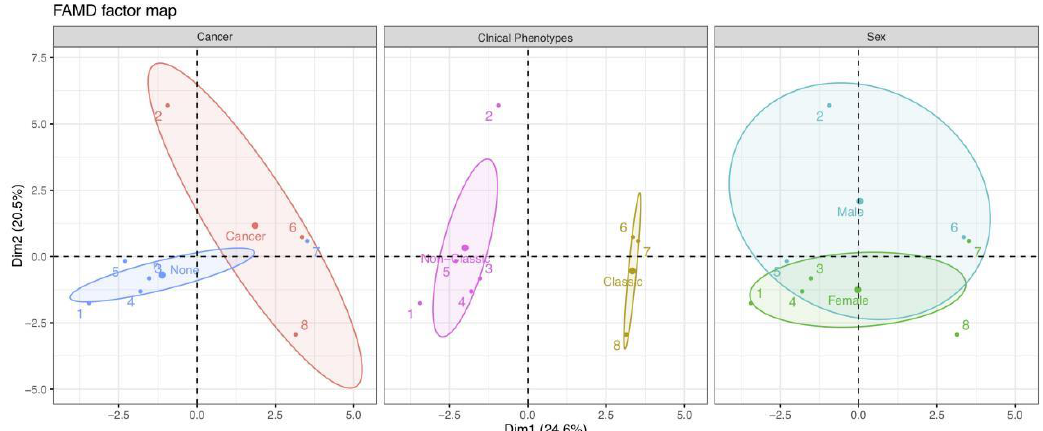
Figure 5. Individual plots corresponding to the classification features of cancer, clinical phenotypes, and sex. Each color represents individuals in a specific feature, and the confidence ellipses indicate their potential relationships. Abbreviation: Dim, dimension.